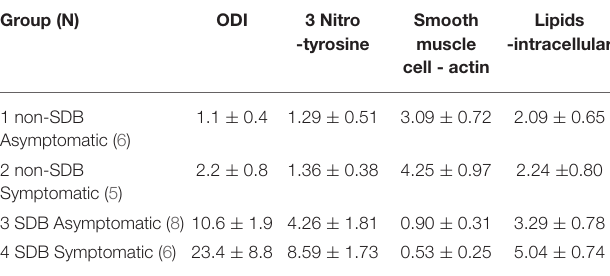
Cellular plaque components (by % stained area) were statistically analyzed for these markers. N, number of patients in each group. Significance for 3-nitrotyrosine, group 4 vs. group 1, p < 0.007; smooth muscle cell–actin (SMC-actin), group 4 vs. group 1, and group3vs.group1,p < 0.03;intracellular lipids,group4vs.group1,p < 0.01.Asmaller number of patients’ plaques were analyzed for smooth muscle cell actin—in groups 1, 2, and 4 only plaques of three patients were determined and in group 3, plaques of four patients were determined. Data are presented as average ±